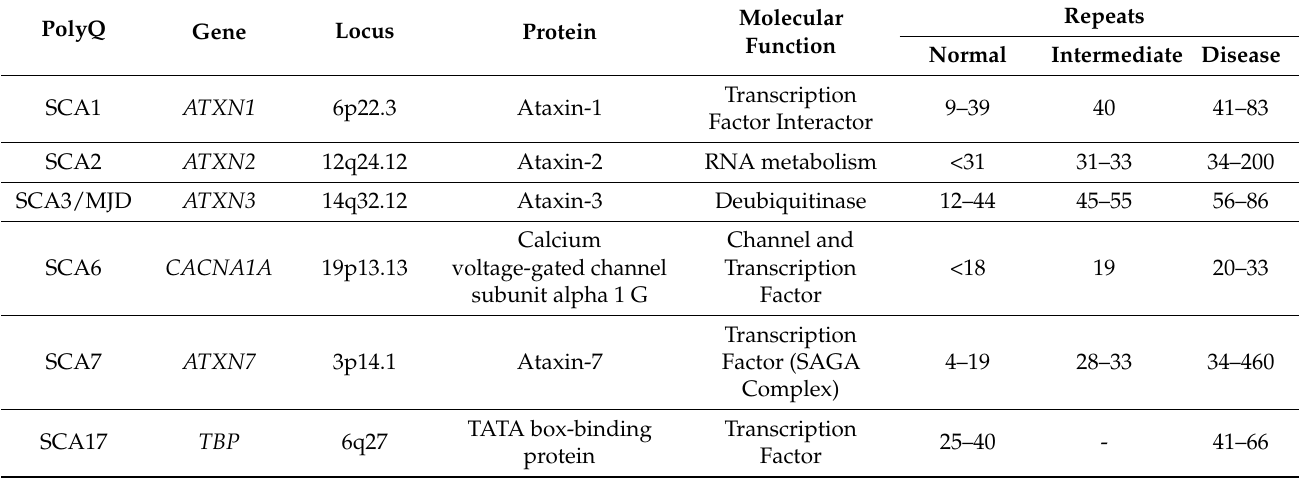
Table 1. Classification of autosomal dominant spinocerebellar ataxia with CAG expansions .